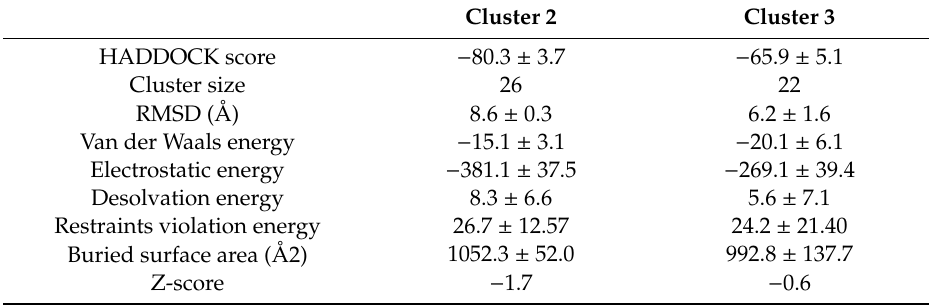
Table 1. HADDOCK docking statistics for the two best clusters. All energies are given in kcal / mol. RMSD represents the root-mean-square deviation of the cluster from the overall lowest energy structure. The Z-score indicates how many standard deviations from the average the cluster is located in terms of score (the more negative, the